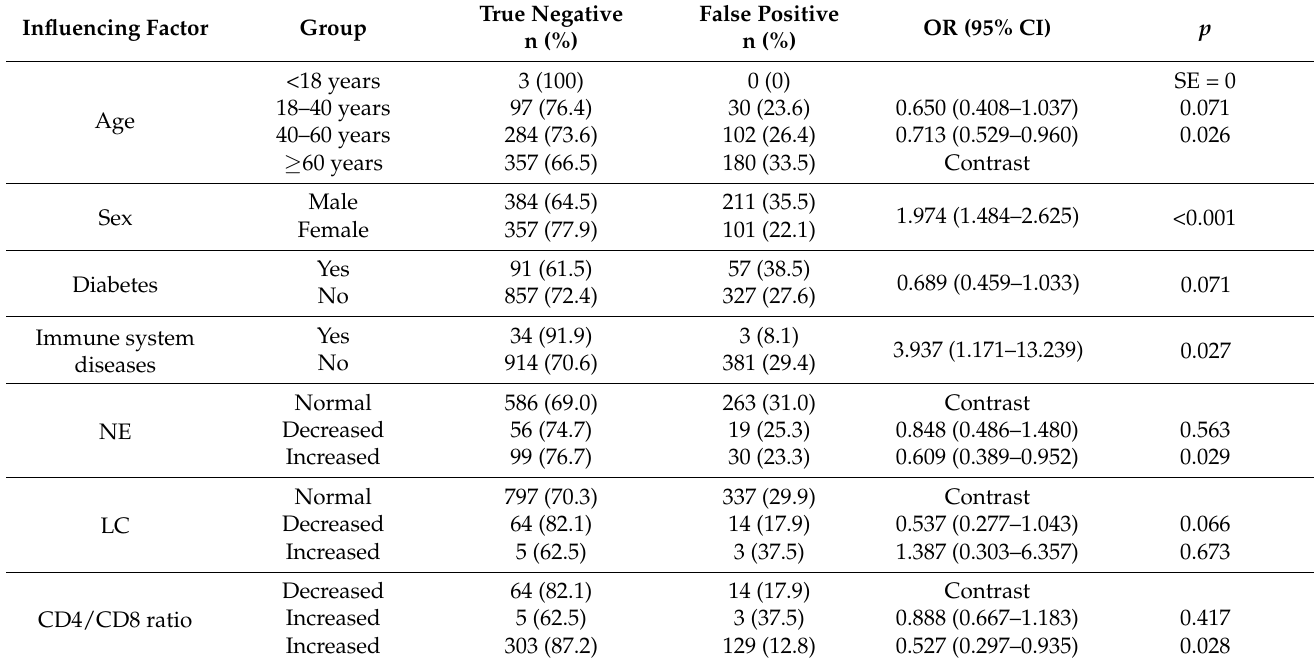
Table 5. Multivariate risk analysis of false-positive and true-negative QFT-GIT results in the diagnosis of active